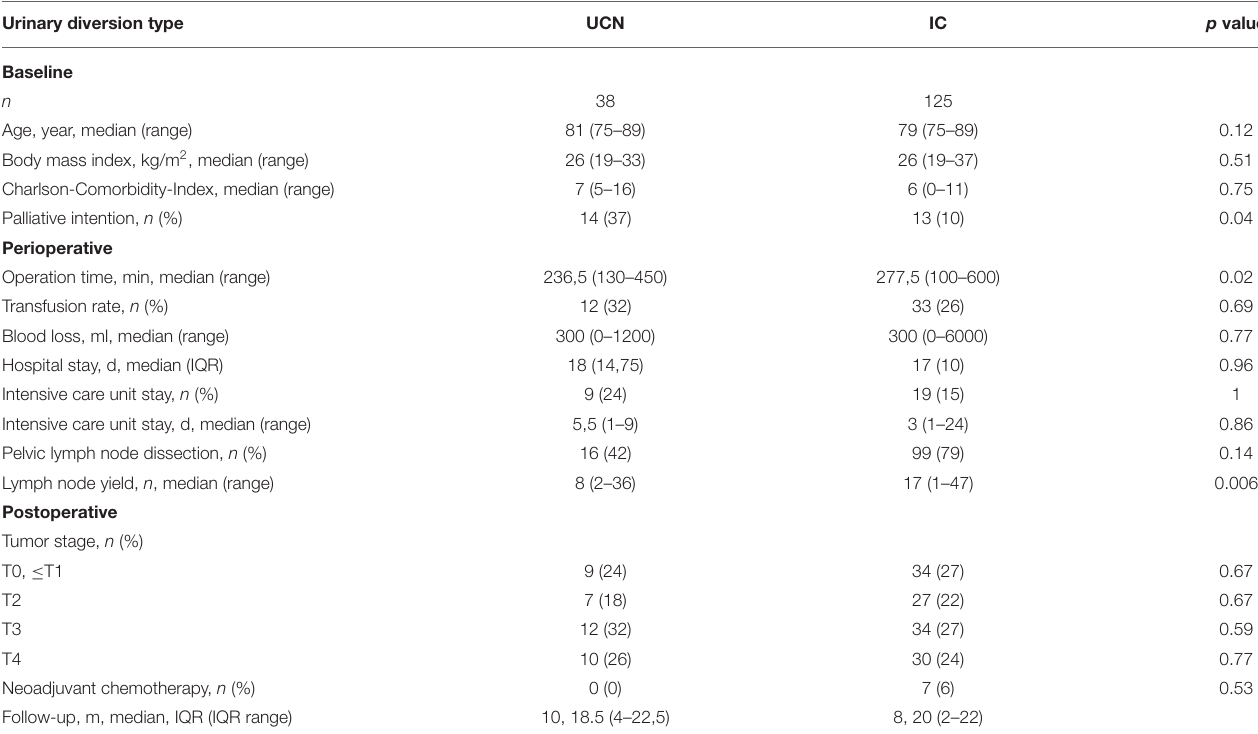
TABLE 1 | Baseline characteristics overall